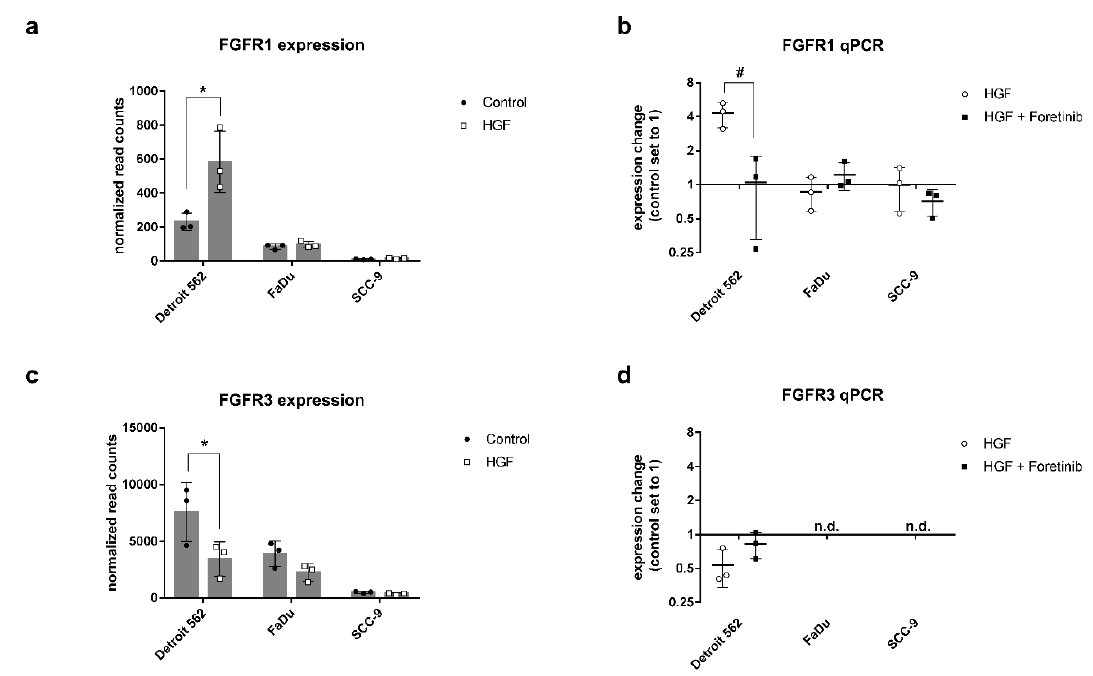
Figure 7. Di ff erential expression of genes of the FGFR family. ( a , c ) Diagrams show normalized gene expression levels resulting from RNA sequencing for FGFR1 ( a ), and FGFR3 ( c ). HGF-stimulated samples are shown in grey, untreated controls in black. *: p adj < 0.1. ( b , d ) qPCR results for FGFR1 and FGFR3. RNA was isolated after 20 h of stimulation with 0.6 nM HGF or HGF and foretinib (500 nM). Shown are expression changes in relation to the untreated control, which was set to one. #: p < 0.05. n.d.: not detectable.